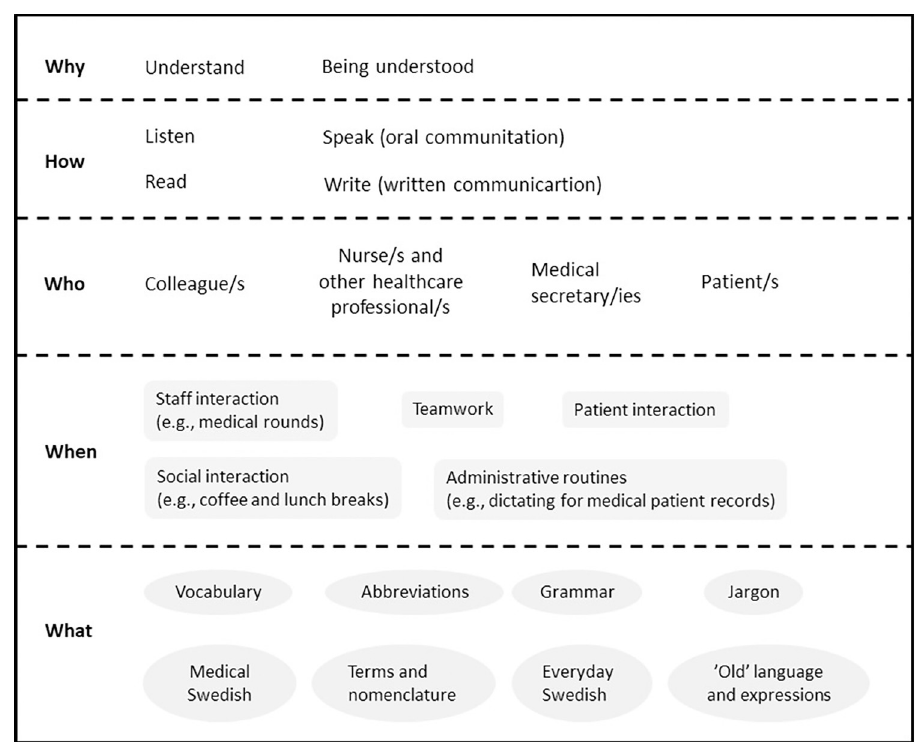
Fig 1. Migrant physicians’ language knowledge needs: Why, how, who, when, and what.